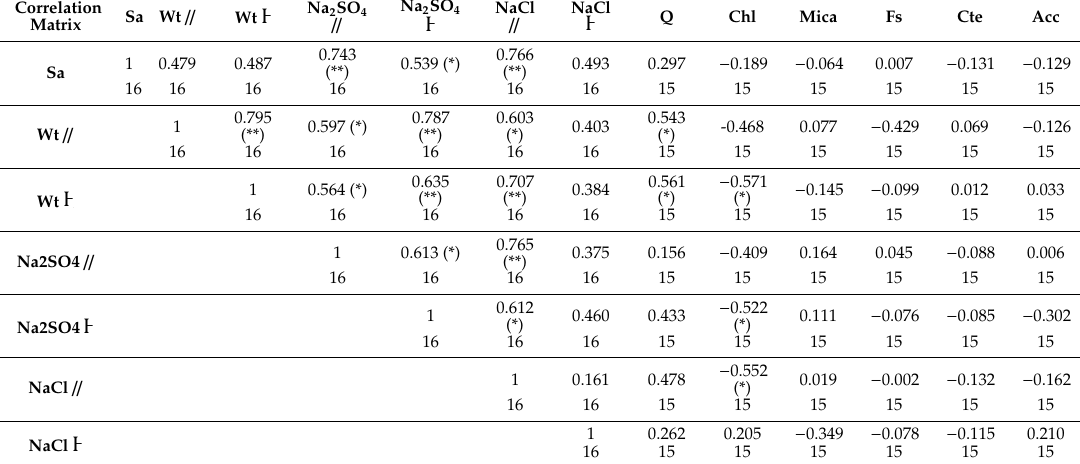
Table 3. Pearson correlation for the results from Table 2. Sa is taken as the value for the arithmetic height. Correlations significant to 0.01 are marked ** , while correlations significant to 0.05 are marked Minerals 2020 , 10 , x FOR PEER REVIEW * . Correlations between mineral components have not been included, since they are not relevant to this study. Sample SPT has not been included for the mineralogical correlation due to its special mineralogy (Table 2). Table 2. Results for the determination of roughness (RUG), capillary ascension, and mineralogy. Mineral abbreviations are Q: Quartz, Chl: Chlorites, Fs: Feldspars, Cte: Table 2. Results for the determination of roughness (RUG), capillary ascension, and mineralogy. Mineral abbreviations are Q: Quartz, Chl: Chlorites, Fs: Feldspars, Cte: Table 2. Results for the determination of roughness (RUG), capillary ascension, and mineralogy. Mineral abbreviations are Q: Quartz, Chl: Chlorites, Fs: Feldspars, Cte: Carbonates, Acc: Accessory minerals, Ant: Antigorite, Chy: Chrysotile, Srp: Serpentinite, and Liz: Lizardite. Directions parallel and perpendicular to L 0 are indicated as // Carbonates, Acc: Accessory minerals, Ant: Antigorite, Chy: Chrysotile, Srp: Serpentinite, and Liz: Lizardite. Directions parallel and perpendicular to L 0 are indicated as // Carbonates, Acc: Accessory minerals, Ant: Antigorite, Chy: Chrysotile, Srp: Serpentinite, and Liz: Lizardite. Directions parallel and perpendicular to L 0 are indicated as // NaCl NaCl and Ͱ , respectively. Wt indicates water capillary ascension in cm. Values in parentheses in the capillary results refer to the maximum height reached, as in Figure 7C–D. // and Ͱ , respectively. Wt indicates water capillary ascension in cm. Values in parentheses in the capillary results refer to the maximum height reached, as in Figure 7C–D. and Ͱ , respectively. Wt indicates water capillary ascension in cm. Values in parentheses in the capillary results refer to the maximum height reached, as in Figure 7C–D. CODE denotes the CODE denotes the CODE denotes the Mineralogy (%) Mineralogy (%) RUG Sa Capillary Ascension (cm) CODE CODE (µm) Q Chl Table 2. Results for the determination of roughness (RUG), capillary ascension, and mineralogy. Mineral abbreviations are Q: Quartz, Chl: Chlorites, Fs: Feldspars, Cte: Carbonates, Acc: Accessory minerals, Ant: Antigorite, Chy: Chrysotile, Srp: Serpentinite, and Liz: Lizardite. Directions parallel and perpendicular to L 0 are indicated as // and Ͱ , respectively. Wt indicates water capillary ascension in cm. Values in parentheses in the capillary results refer to the maximum height reached, as in Figure 7C–D. CODE denotes the Table 2. Results for the determination of roughness (RUG), capillary ascension, and mineralogy. Mineral abbreviations are Q: Quartz, Chl: Chlorites, Fs: Feldspars, Cte: Carbonates, Acc: Accessory minerals, Ant: Antigorite, Chy: Chrysotile, Srp: Serpentinite, and Liz: Lizardite. Directions parallel and perpendicular to L 0 are indicated as // and Ͱ , respectively. Wt indicates water capillary ascension in cm. Values in parentheses in the capillary results refer to the maximum height reached, as in Figure 7C–D. CODE denotes the Table 2. Results for the determination of roughness (RUG), capillary ascension, and mineralogy. Mineral abbreviations are Q: Quartz, Chl: Chlorites, Fs: Feldspars, Cte: Carbonates, Acc: Accessory minerals, Ant: Antigorite, Chy: Chrysotile, Srp: Serpentinite, and Liz: Lizardite. Directions parallel and perpendicular to L 0 are indicated as // and Ͱ , respectively. Wt indicates water capillary ascension in cm. Values in parentheses in the capillary results refer to the maximum height reached, as in Figure 7C–D. CODE denotes the Mineralogy (%) RUG Sa Capillary Ascension (cm) CODE (µm) WAM